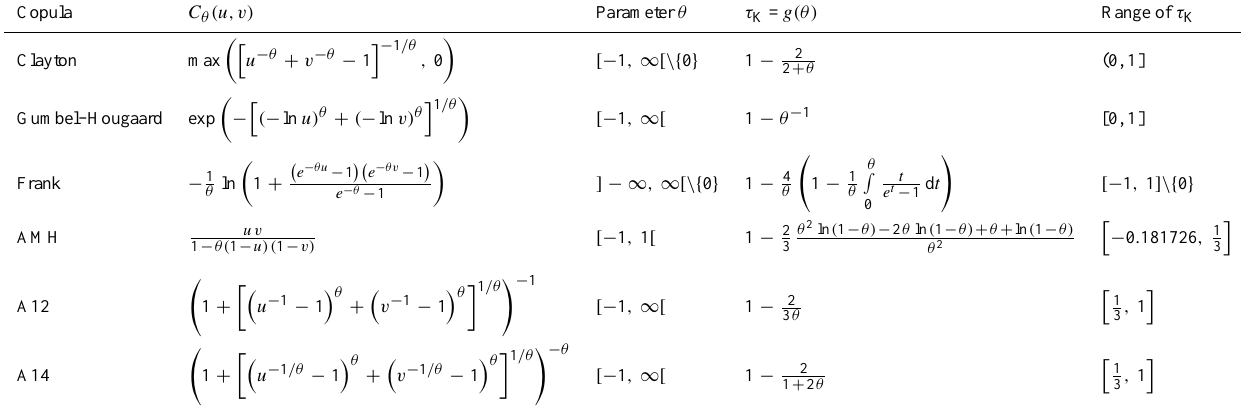
Table 2. Selected copulas and their domain of dependence parameter θ and Kendall’s tau. Copula C θ (u,v) Parameter θ